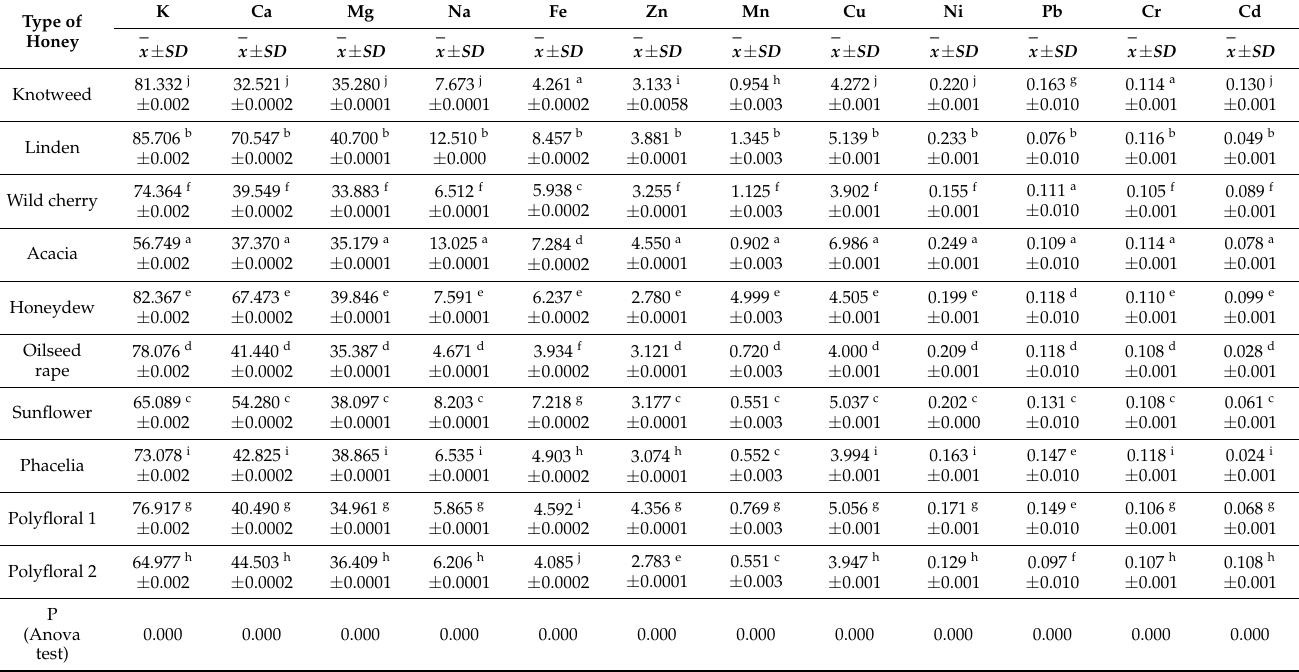
Table 1. The macro and micro-mineral content of the honey in the region of Banat, Romania